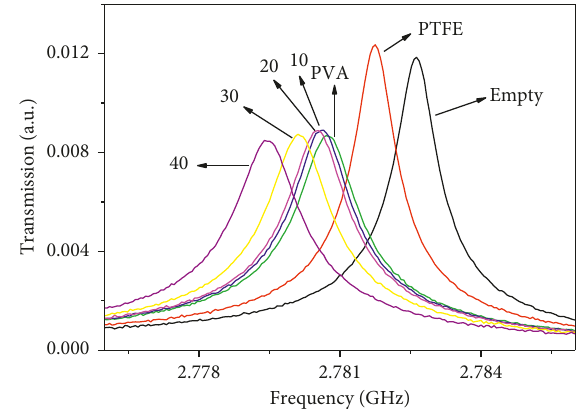
Figure 4: Transmission of the 2.7GHz resonant cavity for PVA, CCTO (x) (for x � 10, 20, 30, 40), PTFE, and empty